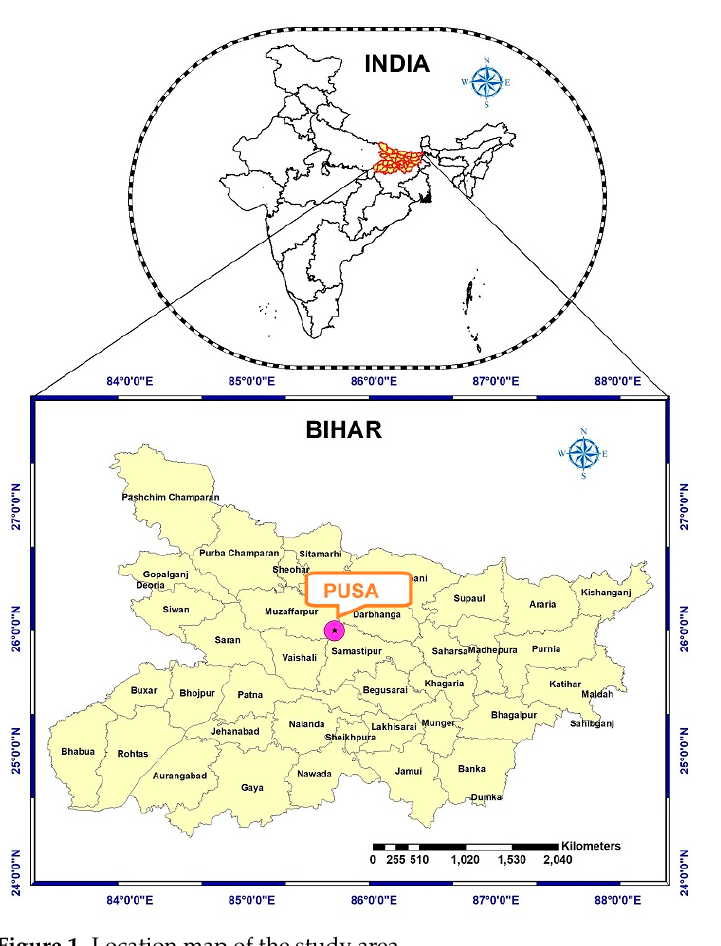
Figure 1. Location map of the study area.